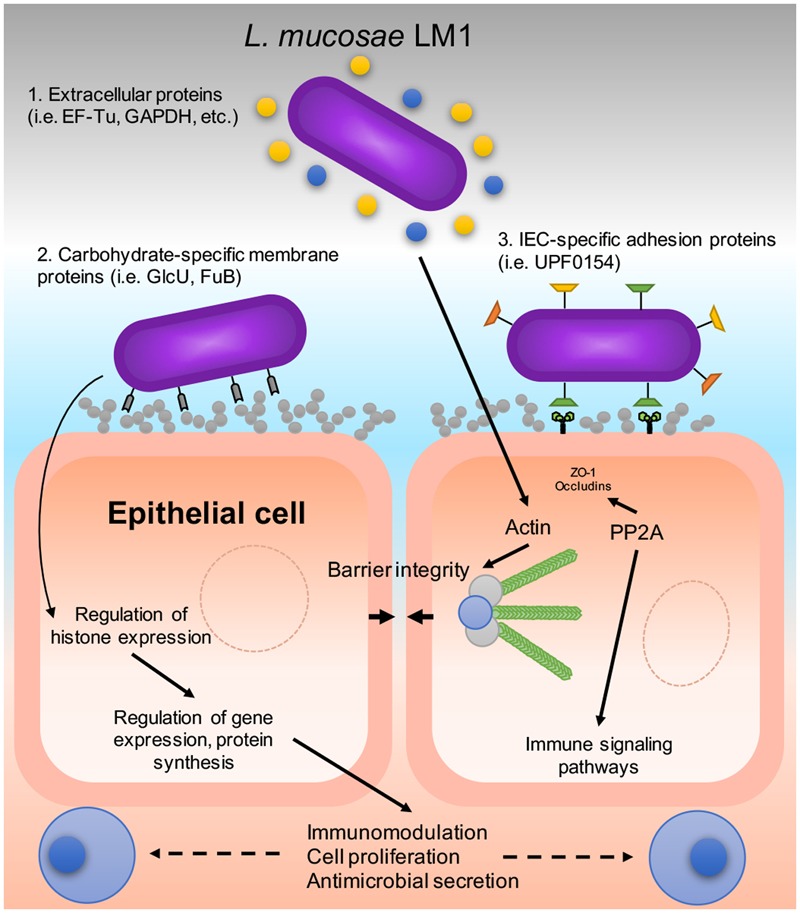
A proposed host–microbe interaction model of LM1 and IPEC-J2 cells. The diagram shows the mechanism of adhesion that could be exhibited by LM1 in various ways: (1) Moonlighting proteins that are secreted externally via the bacterial secretion system, (2) carbohydrate-specific binding proteins, and (3) intestinal epithelial cell (IEC)-specific adhesion proteins. LM1 establishment can influence IEC function by regulating tight junction (TJ) and barrier integrity via TJ dephosphorylation and actin regulation. Histone levels and post-translational mechanisms are also influenced by LM1 that may lead to gene regulation, the secretion of host antimicrobial compounds, and immunomodulation.